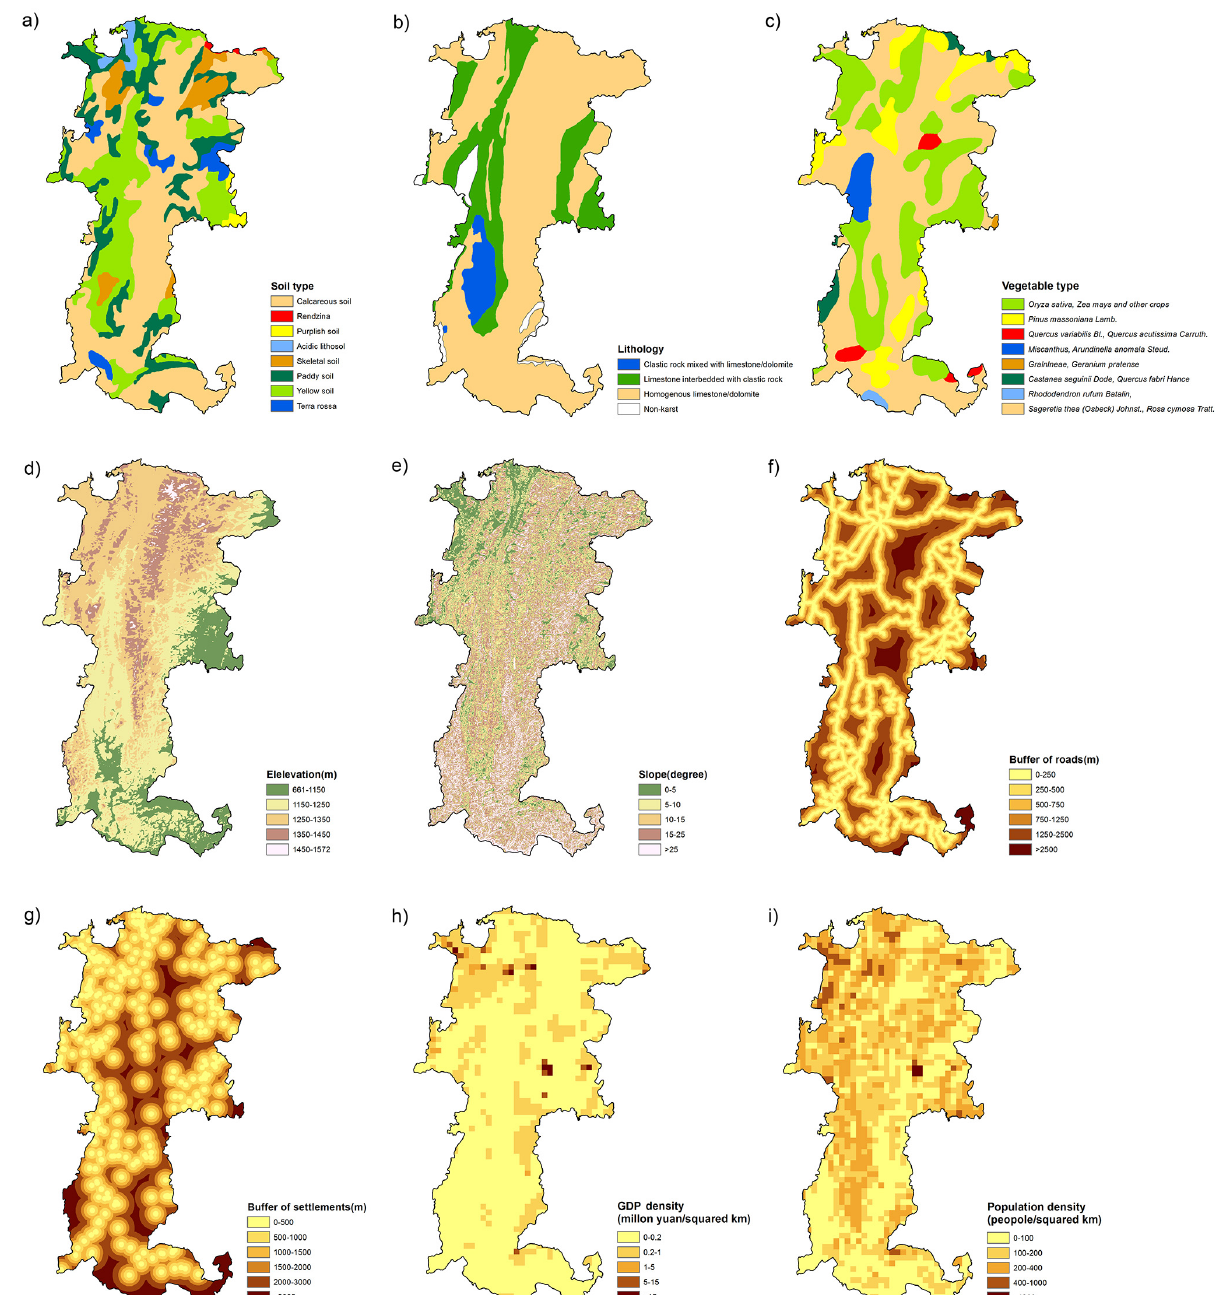
Figure 2. Driving database of the evolution of karst rocky desertification (a) soil type; (b) lithology; (c) vegetable type; (d) elevation; (e) slope; (f) road influence; (g) settlement influence; (h) gross domestic product density; (i) population